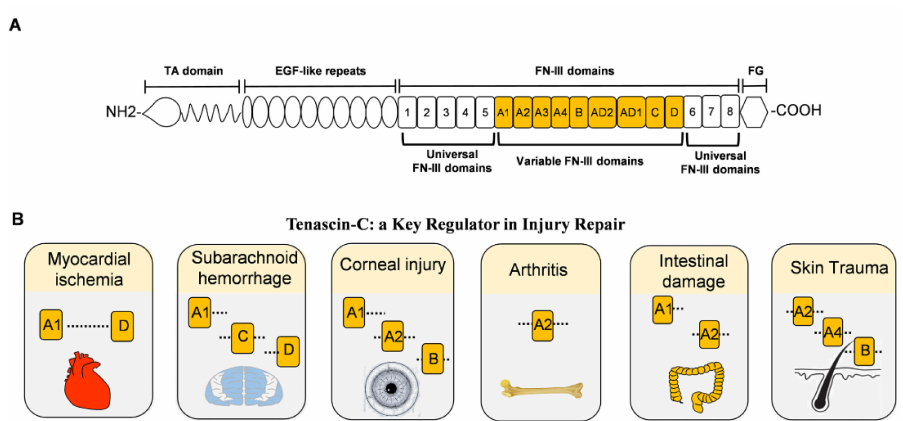
Figure 1. The structure of TNC and damage-related variable FNIII domains. ( A ). Full-length domain of human TNC protein. From the N-terminal to the C-terminal includes the tenascin assembly domain (TA), epidermal growth factor-like (EGF-L) repeat, fibronectin type III (FN III) domain, and fibrinogen globulin (FG) domain. The FNIII domains include eight fixed FNIII domains and nine variable FNIII domains. ( B ). The role of the variable FNIII domains in different injuries. All variable FNIII domains play a role in myocardial infarction. A1, C, and D domains aggravate the symptoms of subarachnoid hemorrhage. Corneal injury exhibits A1, A2, and B domains abnormally, while arthritis expresses the A2 domain leading to synovial injury. In intestinal damage, A1 and A2 domains aggravate intestinal bleeding. For skin trauma, domains A2, A4, and B are associated with